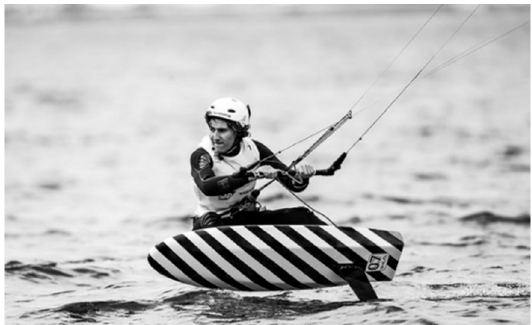
Figure 1. Formula Kite class sailor.